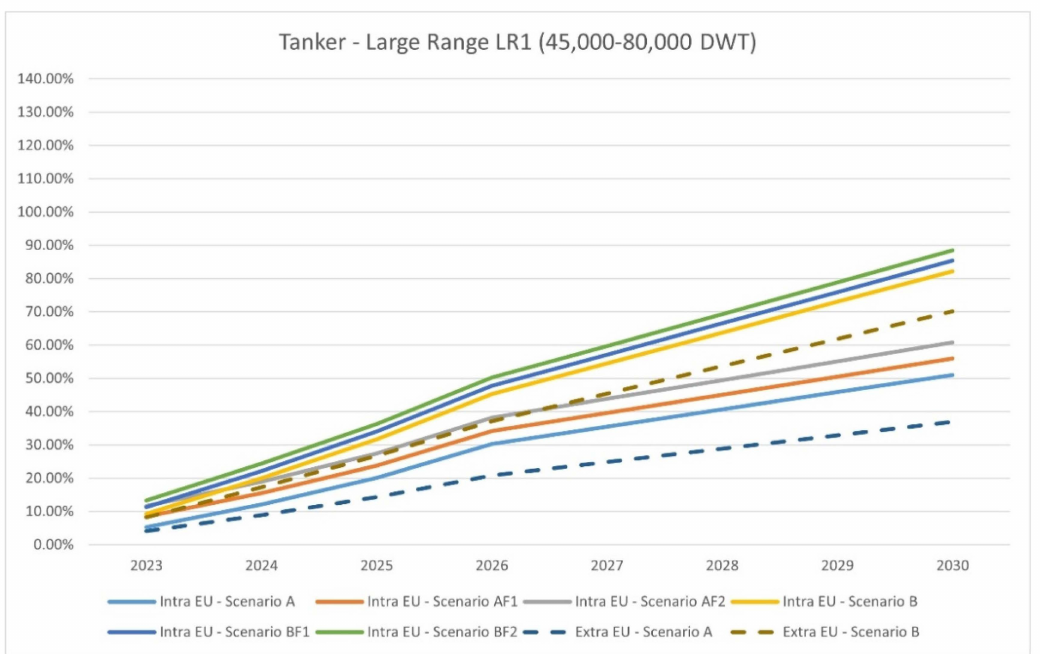
Figure 6. Effect of different scenarios on the OPEX of Panamax containers (5000–6000 TEU).